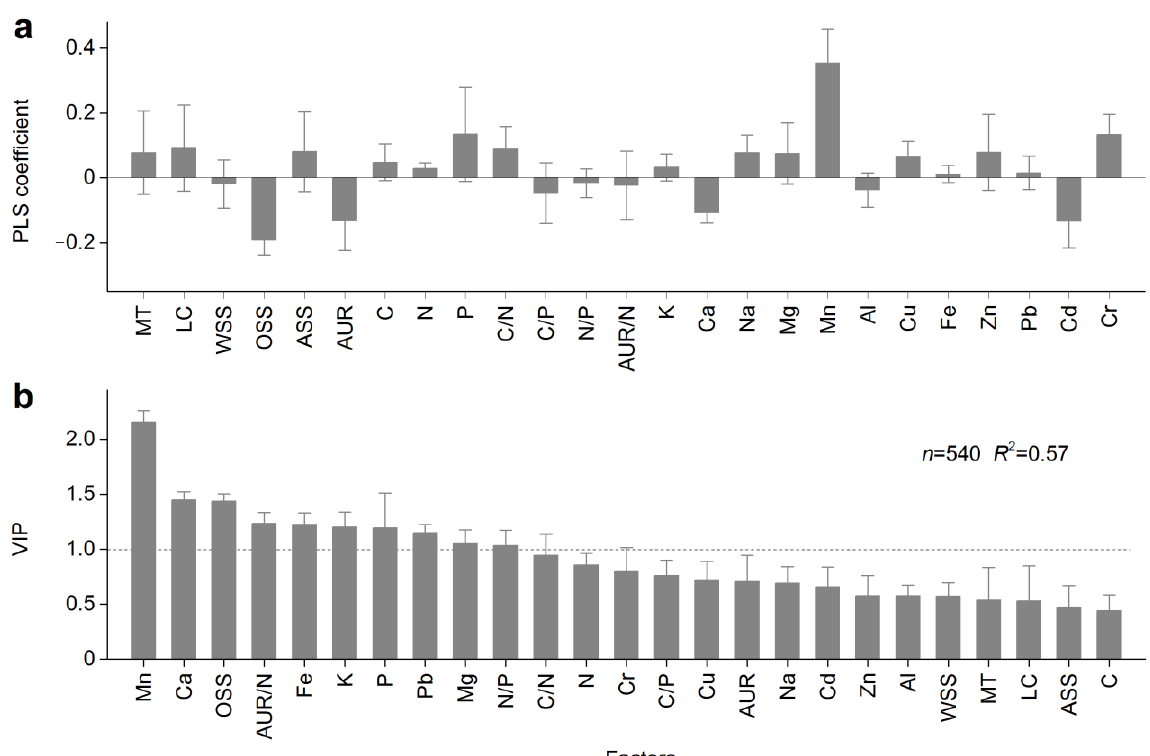
Figure 4. Partial least squares (PLS) analysis results for testing factors that impacted the humus content. ( a ) PLS coefficient. ( b ) Variable importance of projection (VIP). Error bars represent standard errors. VIP values greater than 1 (above the dashed line) were significant. MT: mean tempera-